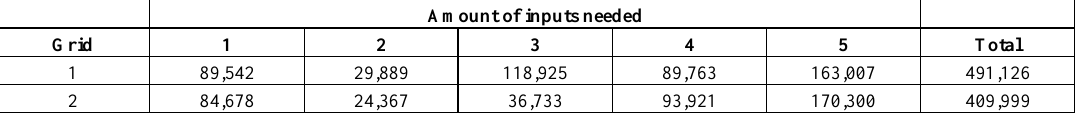
Table 3. Model output on requirements of inputs by each grid to fulfill market demand Amount of inputs needed